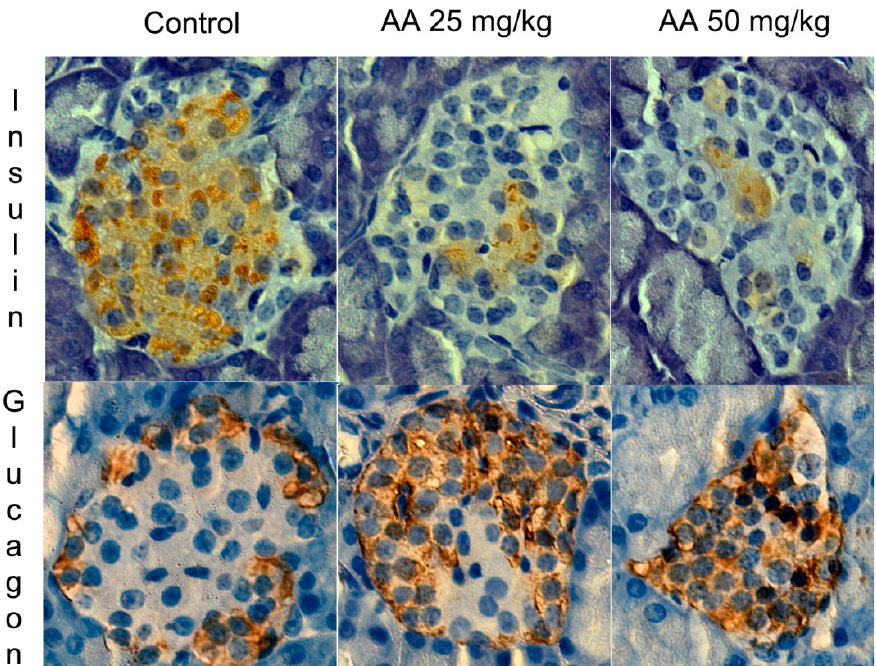
Figure 2. Insulin and glucagon immunohistochemically stained pancreatic islets of control and AA-treated rats. Male Wistar rats were treated with AA in doses of 25 mg/kg b.w./d and 50 mg/kg b.w./d; 400× light microscope magnification [58].